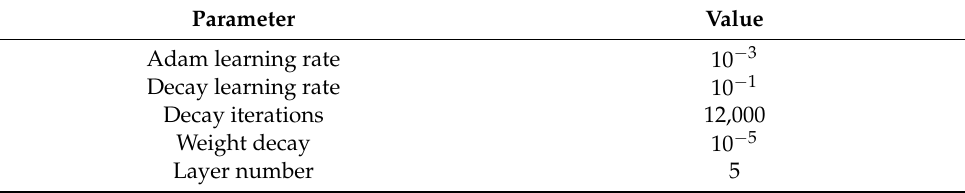
Table 6. Hyperparameter